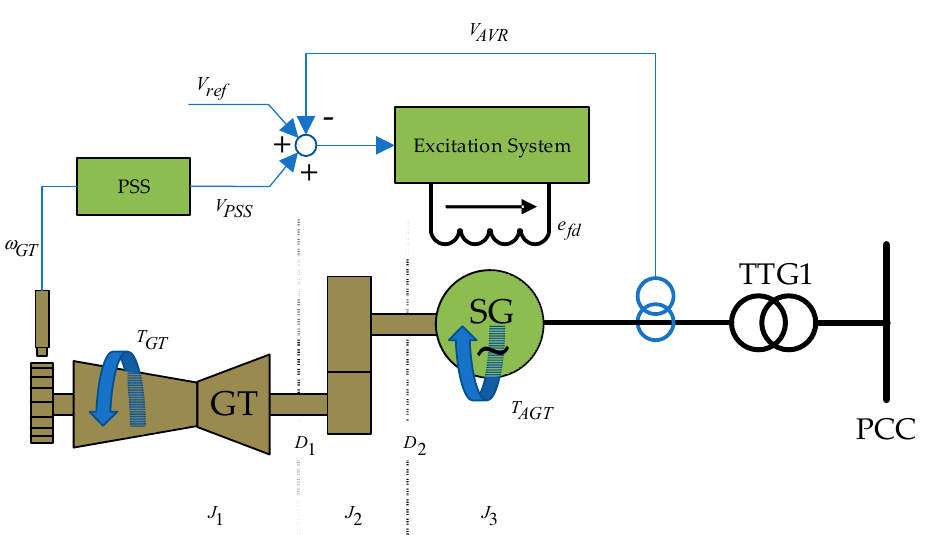
Figure 2. Three Degrees of Freedom (DOFs) equivalent model of a Turbine-Generator (TG) unit.